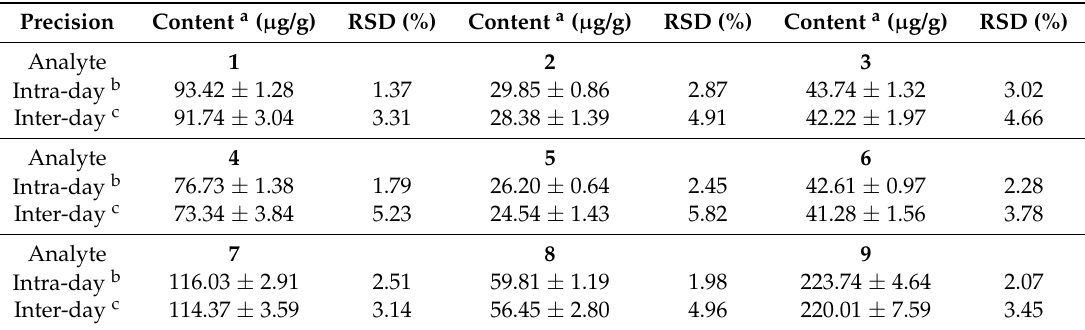
Table 2. Precision of the method for the determination of the nine